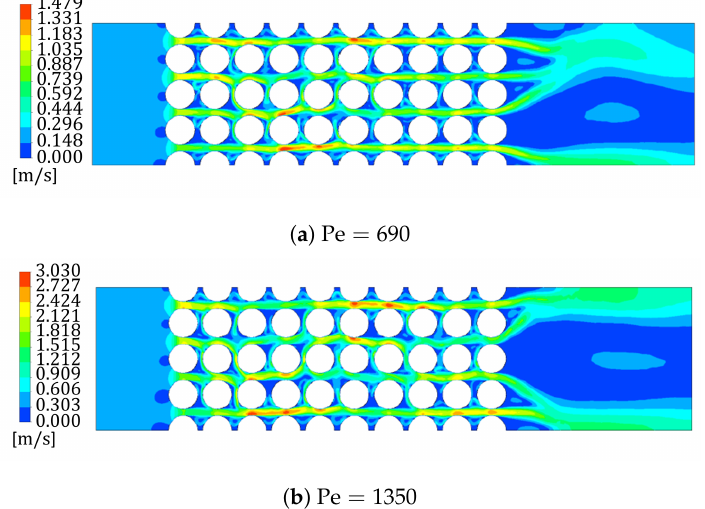
Figure 5. Instantaneous velocity field from compact bank URANS